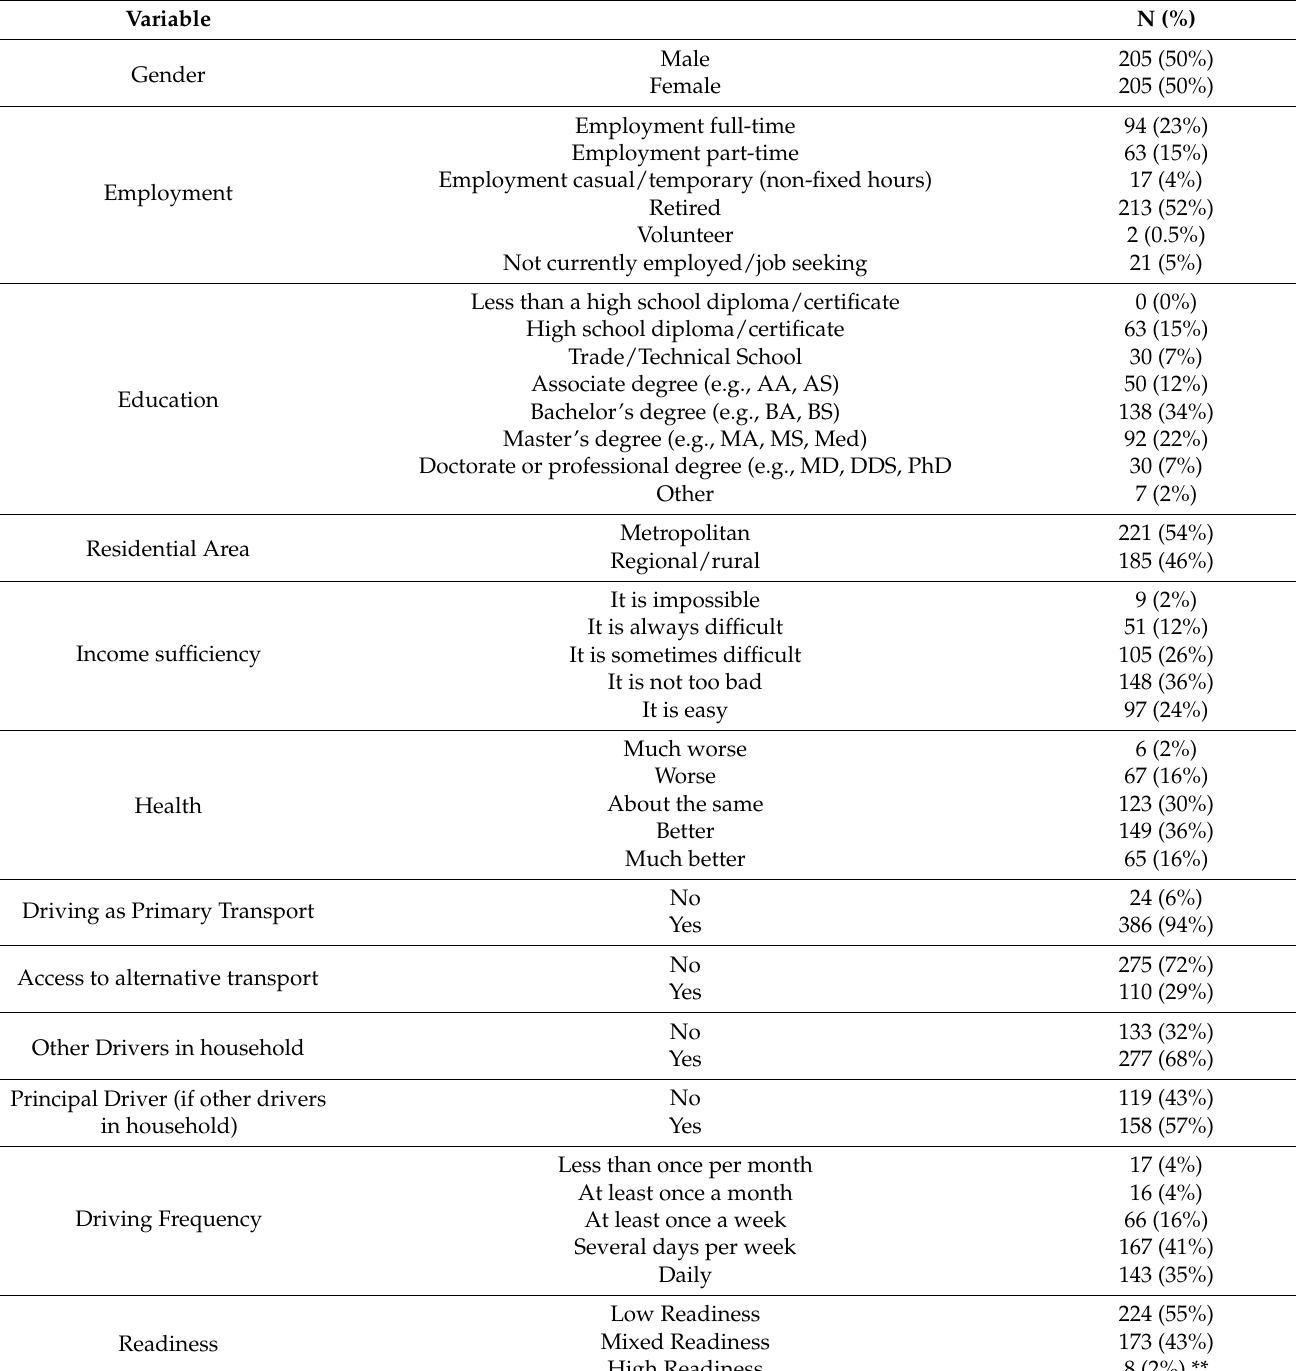
Table 1. Demographic Variables of the